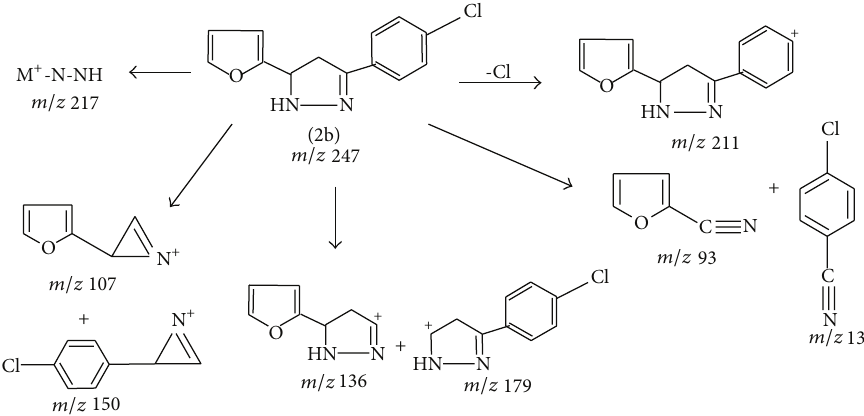
Scheme 1: Fragmentation of Scheme 1.